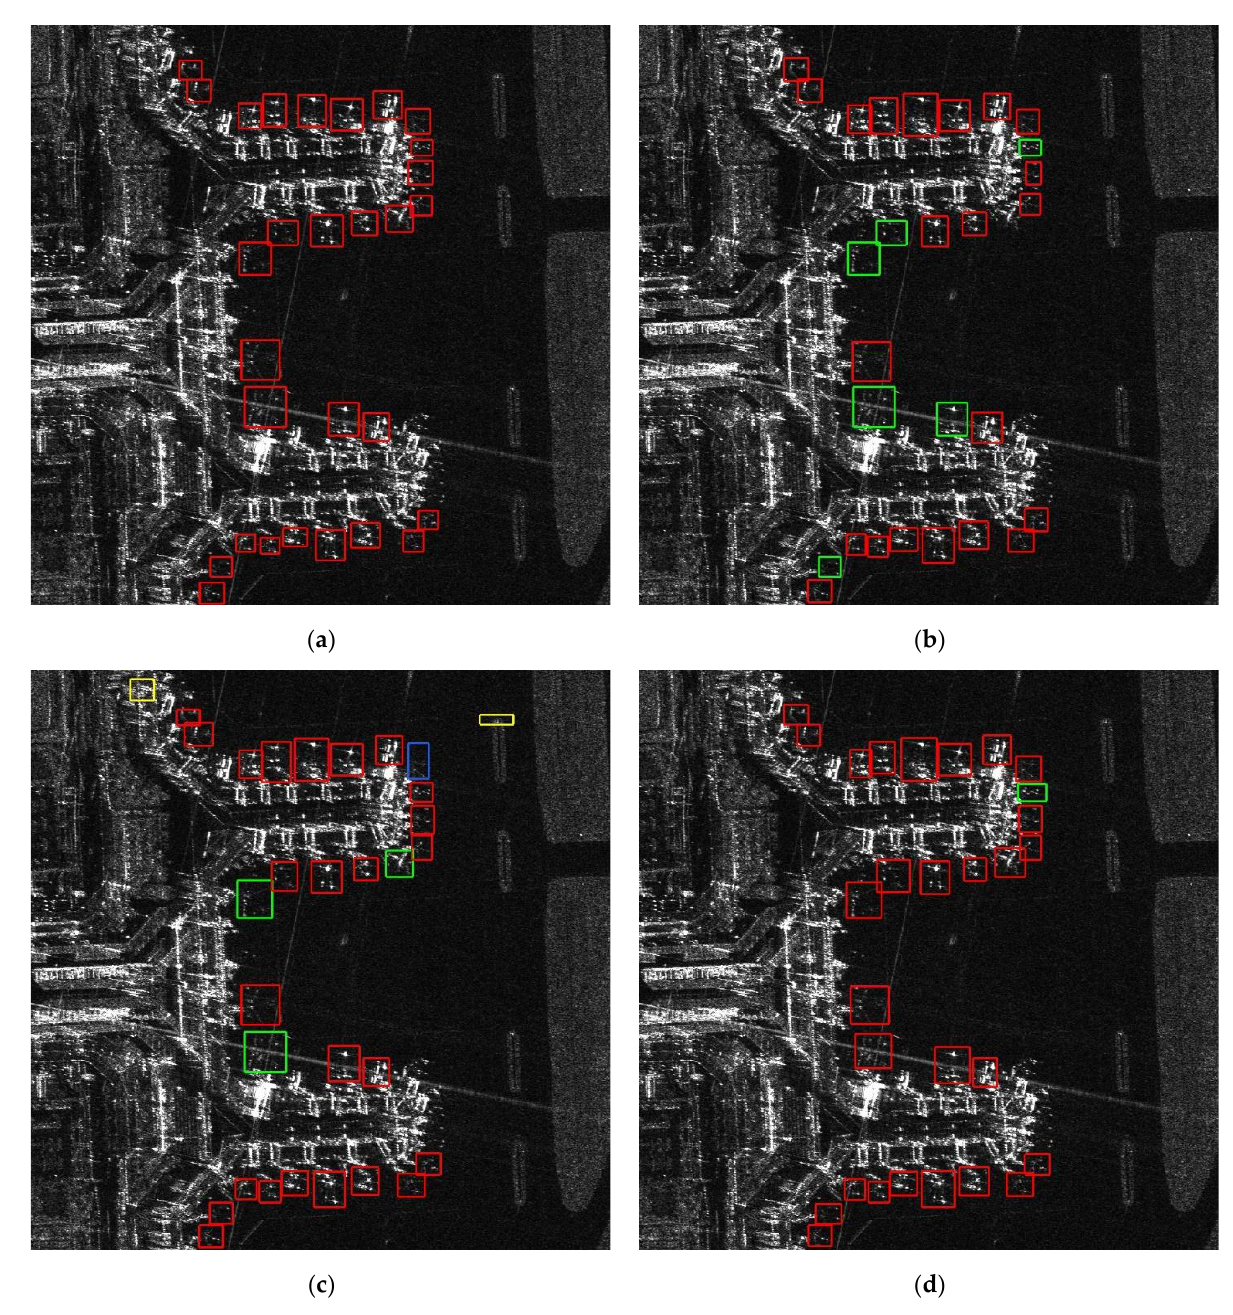
Figure 7. The results for scene II of Shanghai Hongqiao Airport. ( a ) The ground truth from Gaofen-3. ( b-d ) The detection results by YOLOv5, YOLOX, and SOAEN, respectively. The correct detection, the missed detection, the false alarms, and the inaccurate bounding boxes are indicated by red, green, yellow, and blue boxes, respectively.